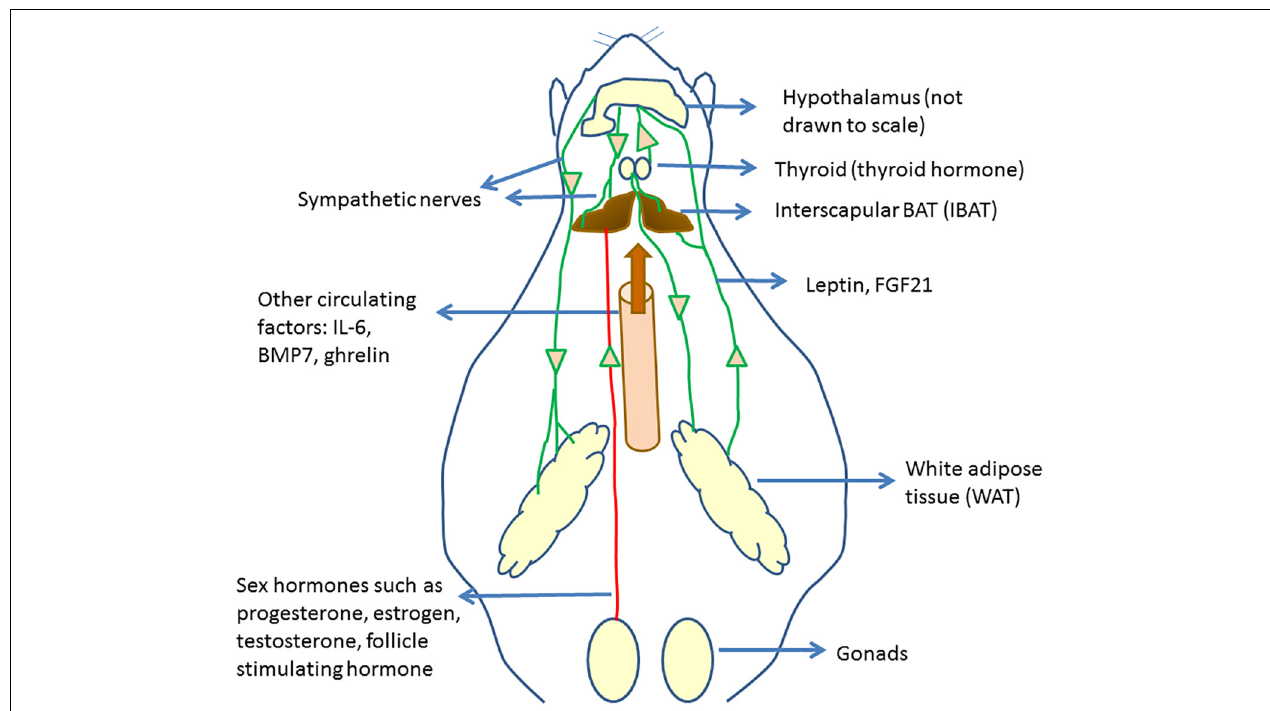
FIGURE 1 | Circulating regulators of BAT and their origin. Hypothalamus plays an important role in regulating brown fat activity through regulating the sympathetic nervous system activity. Several circulating regulators impact BAT functioning and browning. Many of these act through increasing the sympathetic nervous activity to BAT and WAT, increasing UCP1